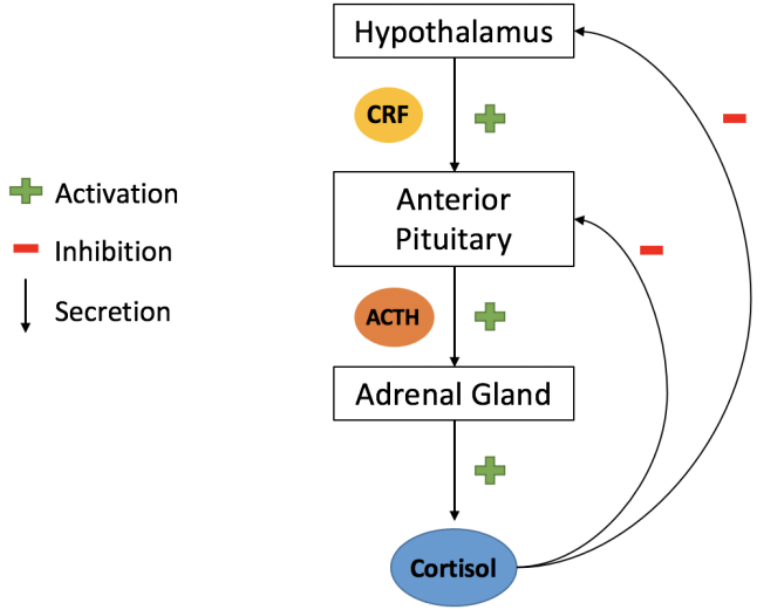
Figure 2. Hypothalamic–pituitary–adrenal (HPA) axis. Upon activation (by a stimulus), the hy- pothalamus releases the corticotrophin-releasing factor (CRF, in yellow), stimulating the anterior gland, which then secretes the adrenocorticotropic hormone (ACTH, in orange). The ACTH, in turn, activates the adrenal gland, which secretes cortisol (in blue). Cortisol inhibits the anterior pituitary gland, as well as the hypothalamus.